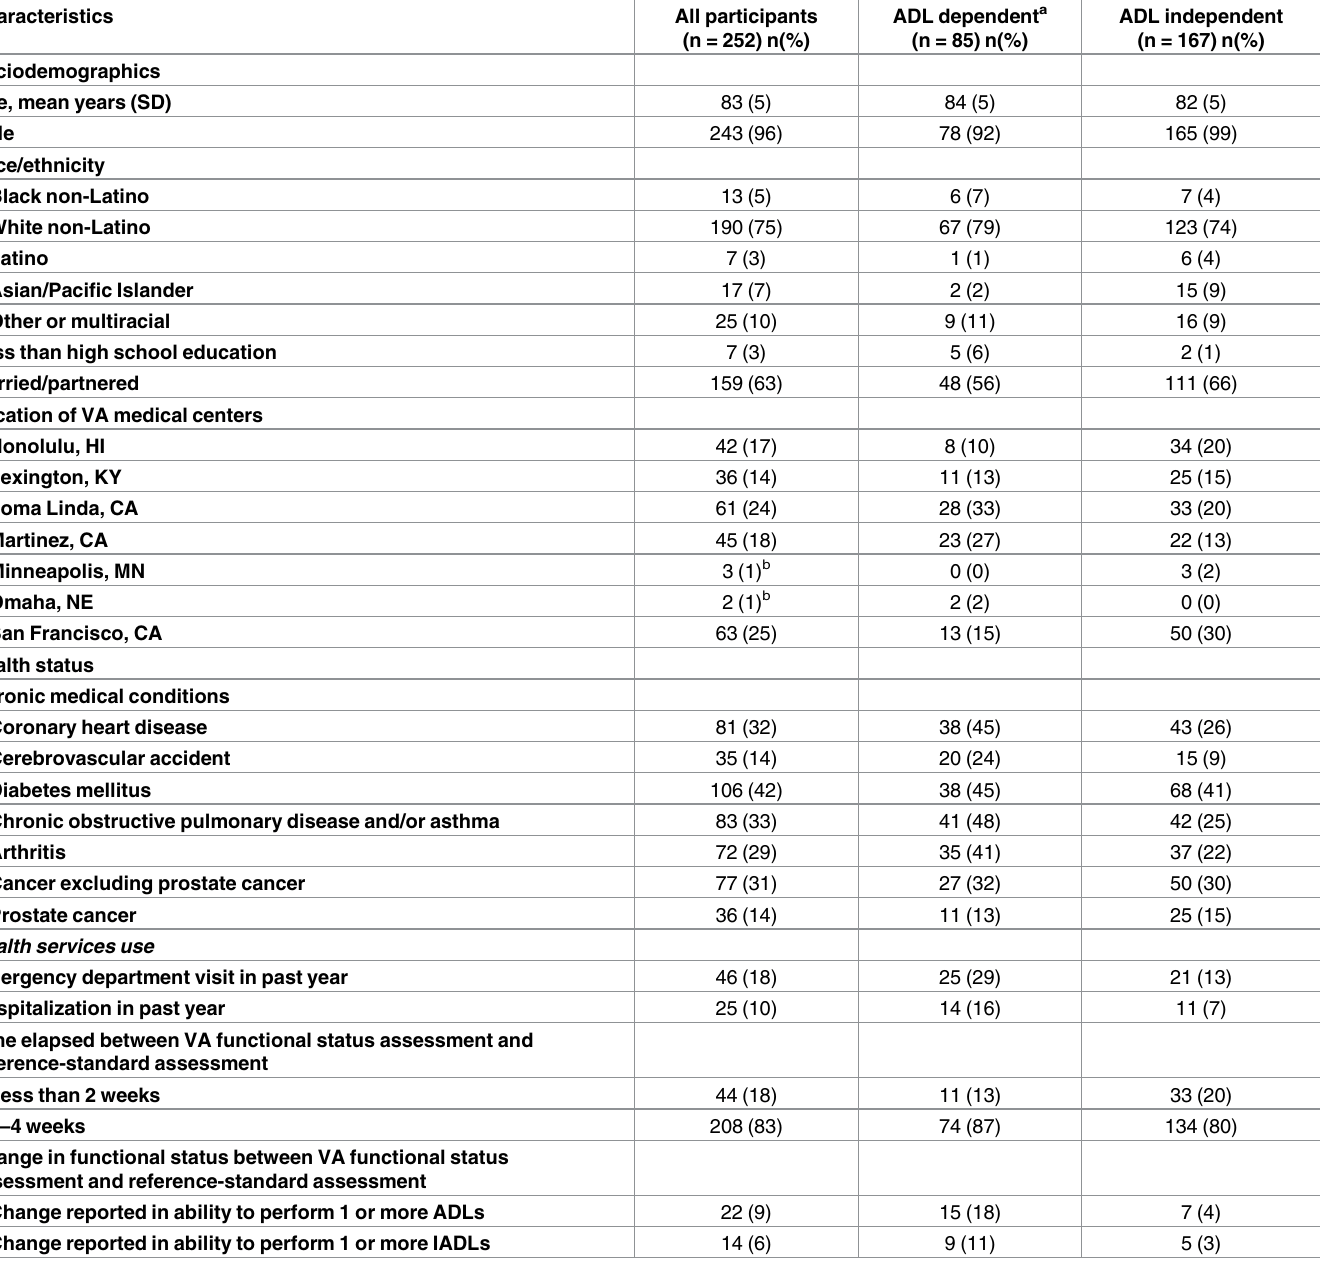
Table 2. Baseline characteristics of